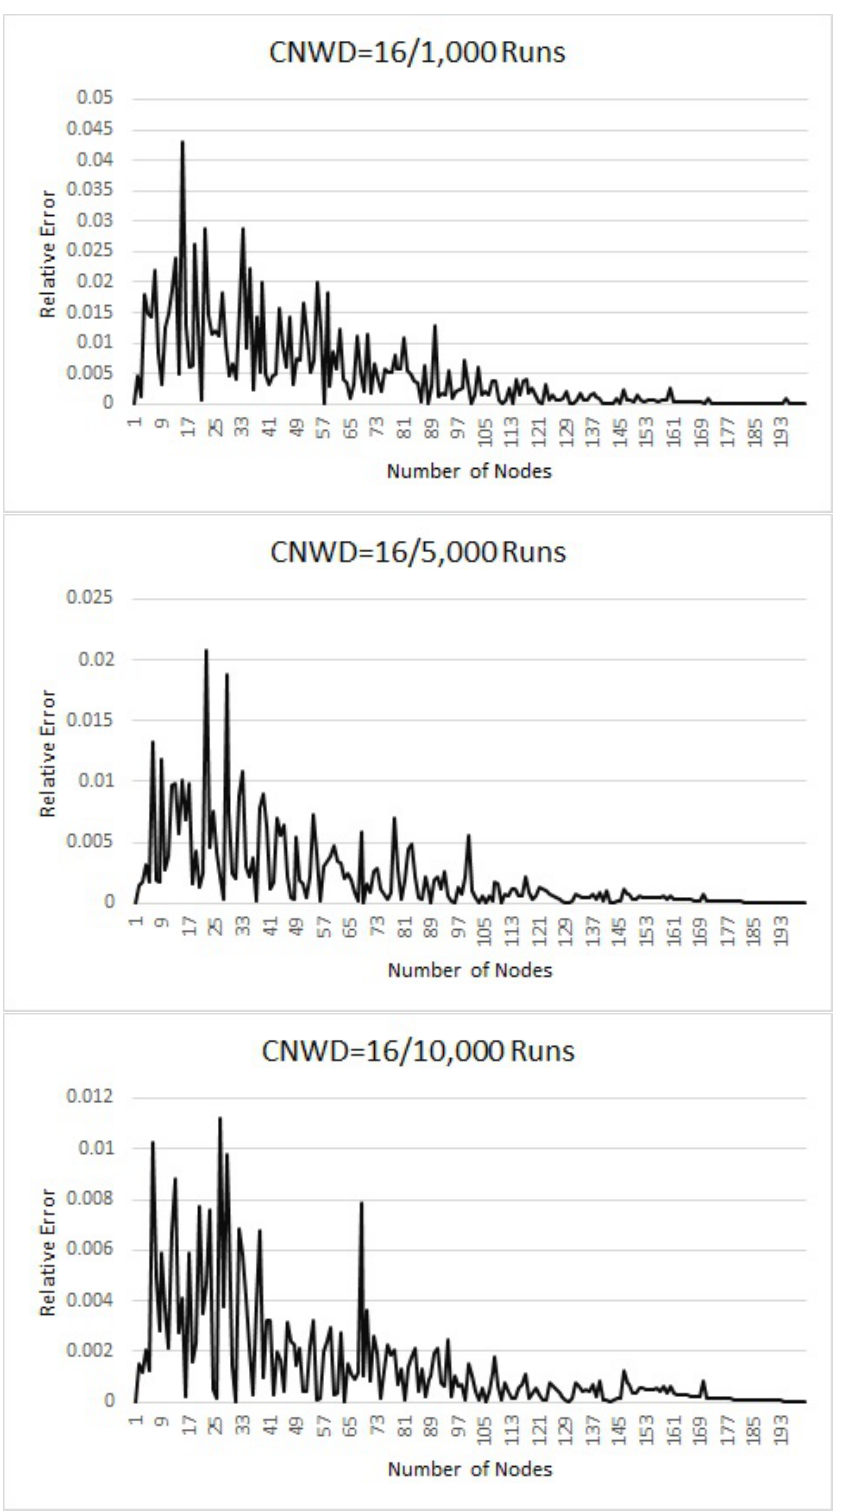
Figure 3. Theoretical vs. Simulated results for CNWD =